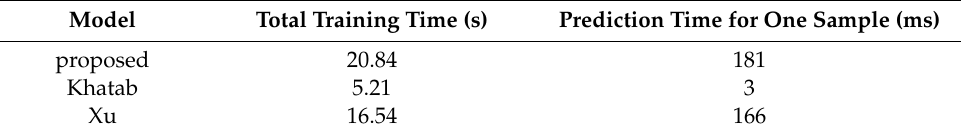
Table 9. Calculation time of di ff erent